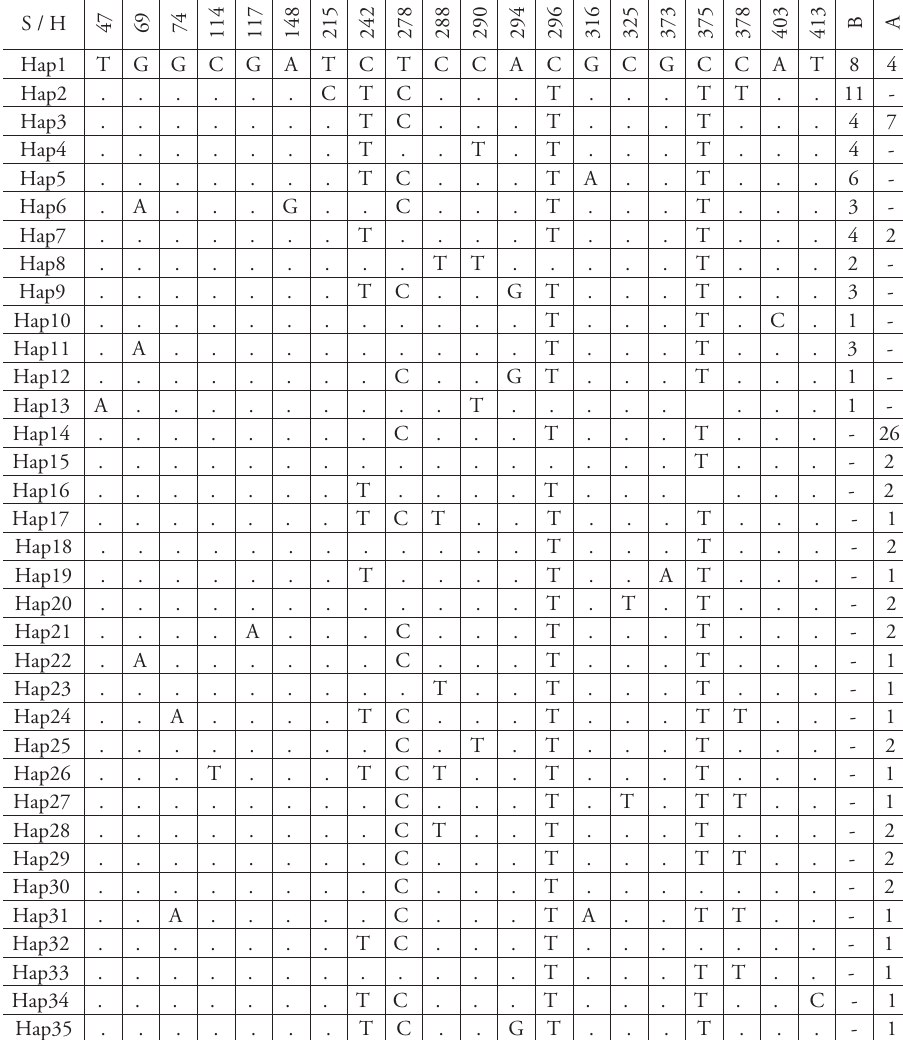
Table 1. Number of domain I Control Region mtDNA haplotypes evidenced by distinct sequences in cattle egret ( Bubulcus ibis ) in two areas: A = Africa; B = Brazil. S / H